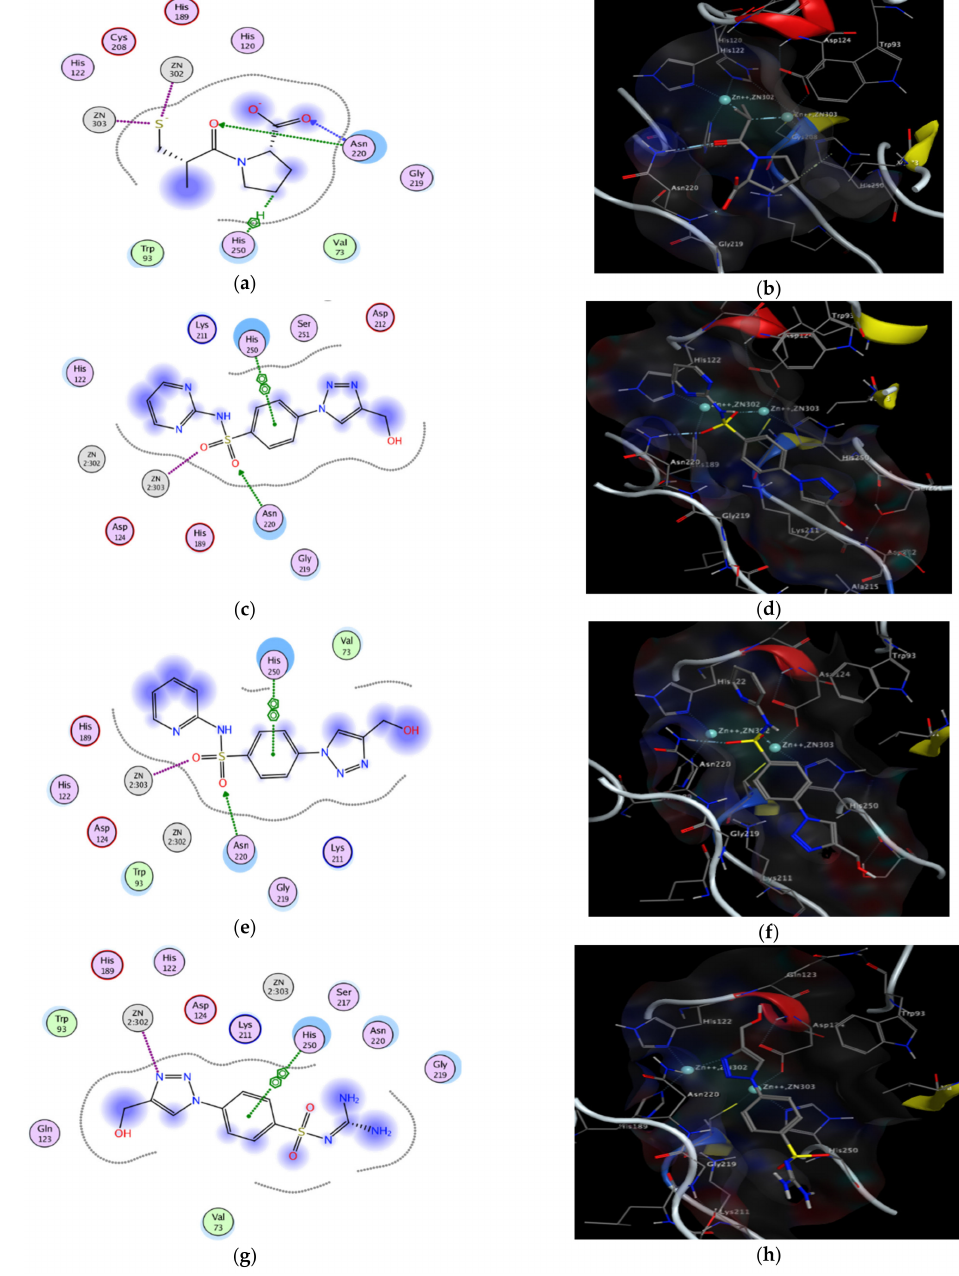
Figure 6. Docking study of the synthesized compounds against NDM-1. ( a ) Two-dimensional binding mode of L-captopril, ( b ) 3D binding mode of L-captopril, ( c ) 2D binding mode of compound 3a , ( d